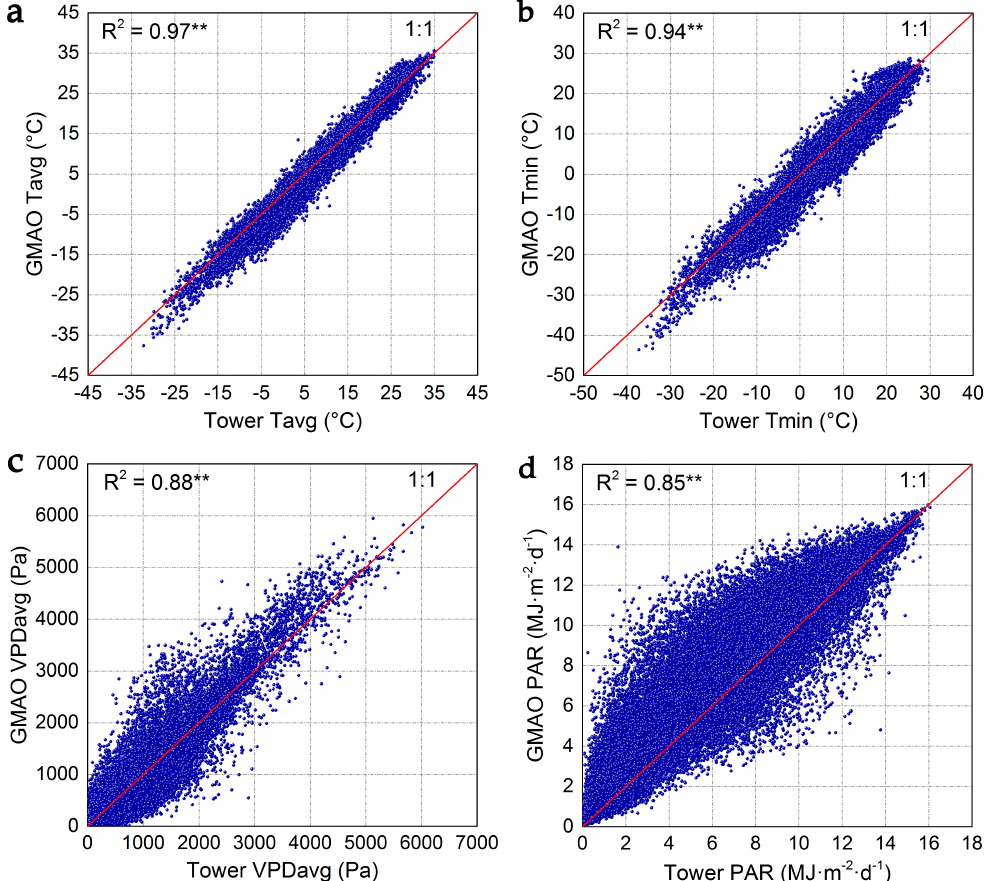
Figure 4. Scatter plots of the daily GMAO meteorology data against the daily site meteorology data